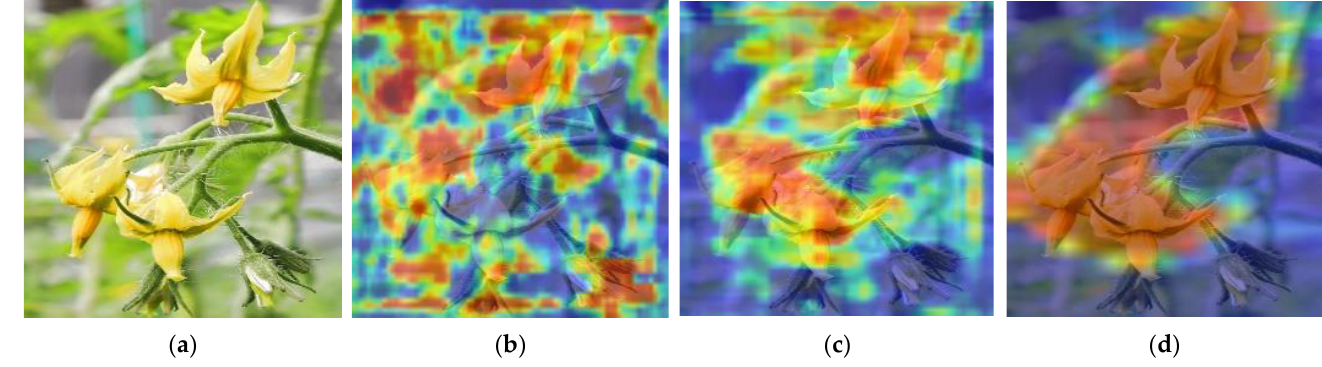
Figure 11. Energy distribution visualization of feature maps before and after adding a feature fusion layer and the CBAM: ( a ) original image; ( b ) original Yolov5; ( c ) Yolov5 with the CBAM added; and ( d ) FlowerYolov5. ( d )